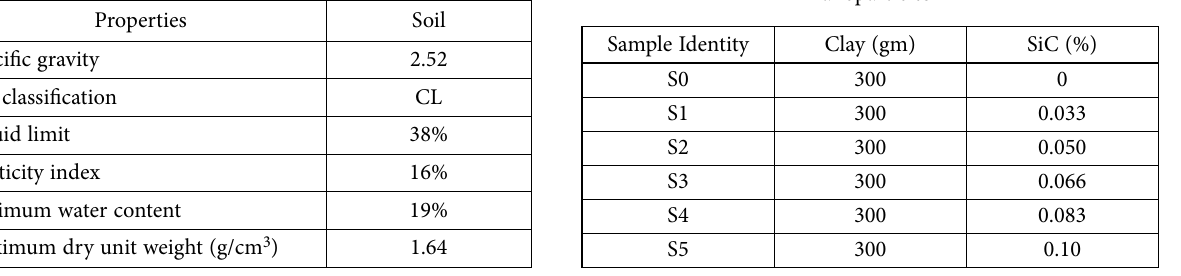
Table 2. Physical and chemical properties of the sample soil Table 3. Synthesis details of nanocomposites of Clay and